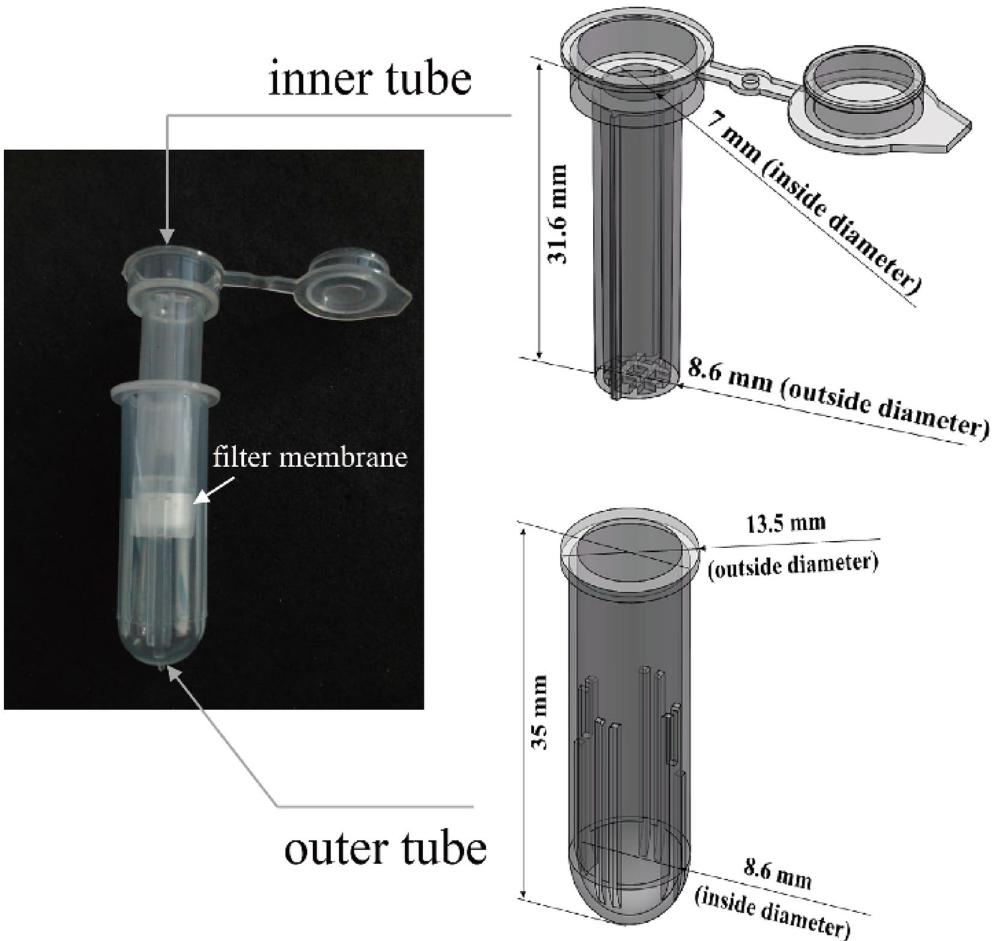
Figure 1. The structure the freeze-drying device. The proposed device consisted of two tubes. The inner tube was used for intercepting the analytes with a membrane, and the outer tube was used for reserving the filtered samples. The inner tube was freeze-dried in a vacuum freeze dryer. The volume of the sample stored in each tube was 200